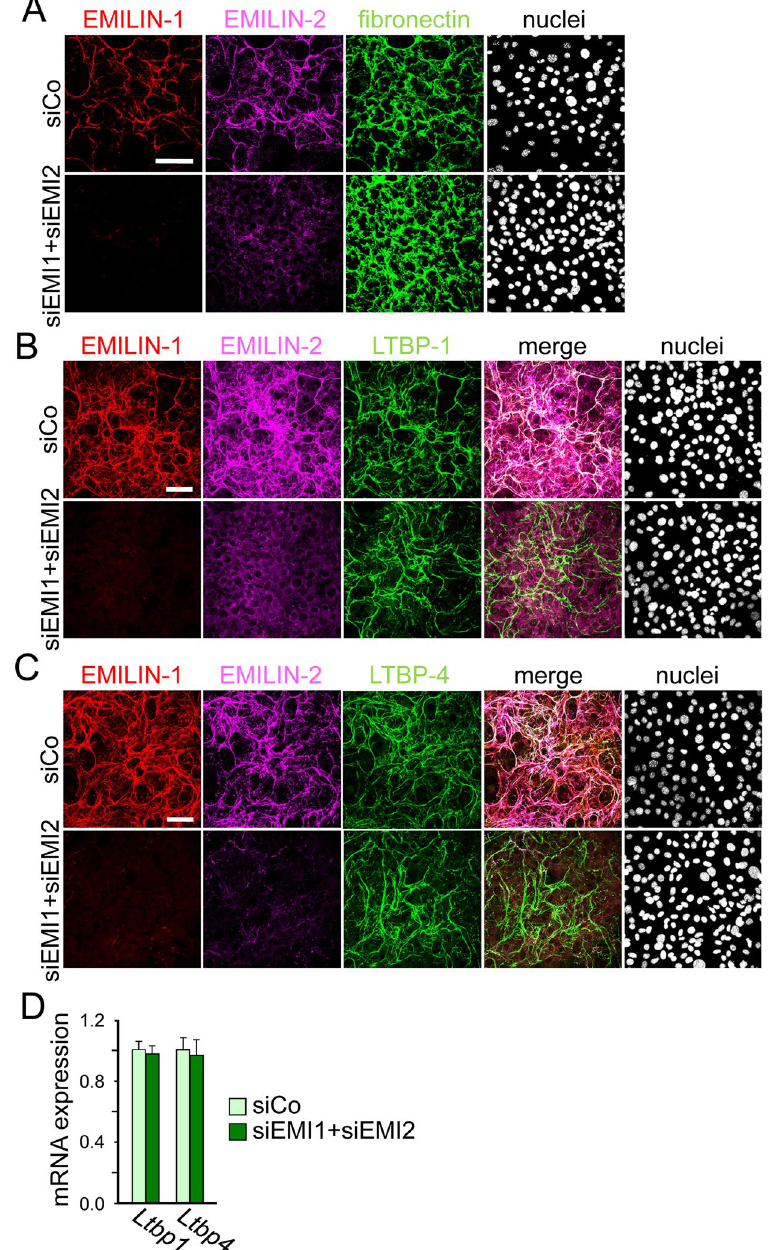
Figure 3. Deposition of fibronectin, LTBP-1 and LTBP-4 in MC3T3-E1 cells after double knockdown of EMILIN-1 and EMILIN-2. MC3T3-E1 osteoblasts were transfected with a mixture of siRNAs against EMILIN-1 (siEMI1) and EMILIN-2 (siEMI2) or with a control siRNA (siCo) and grown for 4 days. ( A , B , C ) Confocal microscopy of cells transfected with the different siRNAs and immunolabeled with antibodies against ( A ) fibronectin, ( B ) LTBP-1 or ( C ) LTBP-4, Scale bar, 75 μ m. Nuclei were stained with Hoechst. ( D ) qRT-PCR analysis of LTBP-1 and LTBP-4 transcripts in cells transfected with the different siRNAs showed no significant differences (n = 3). All siRNA knockdown experiments were performed three times (n =